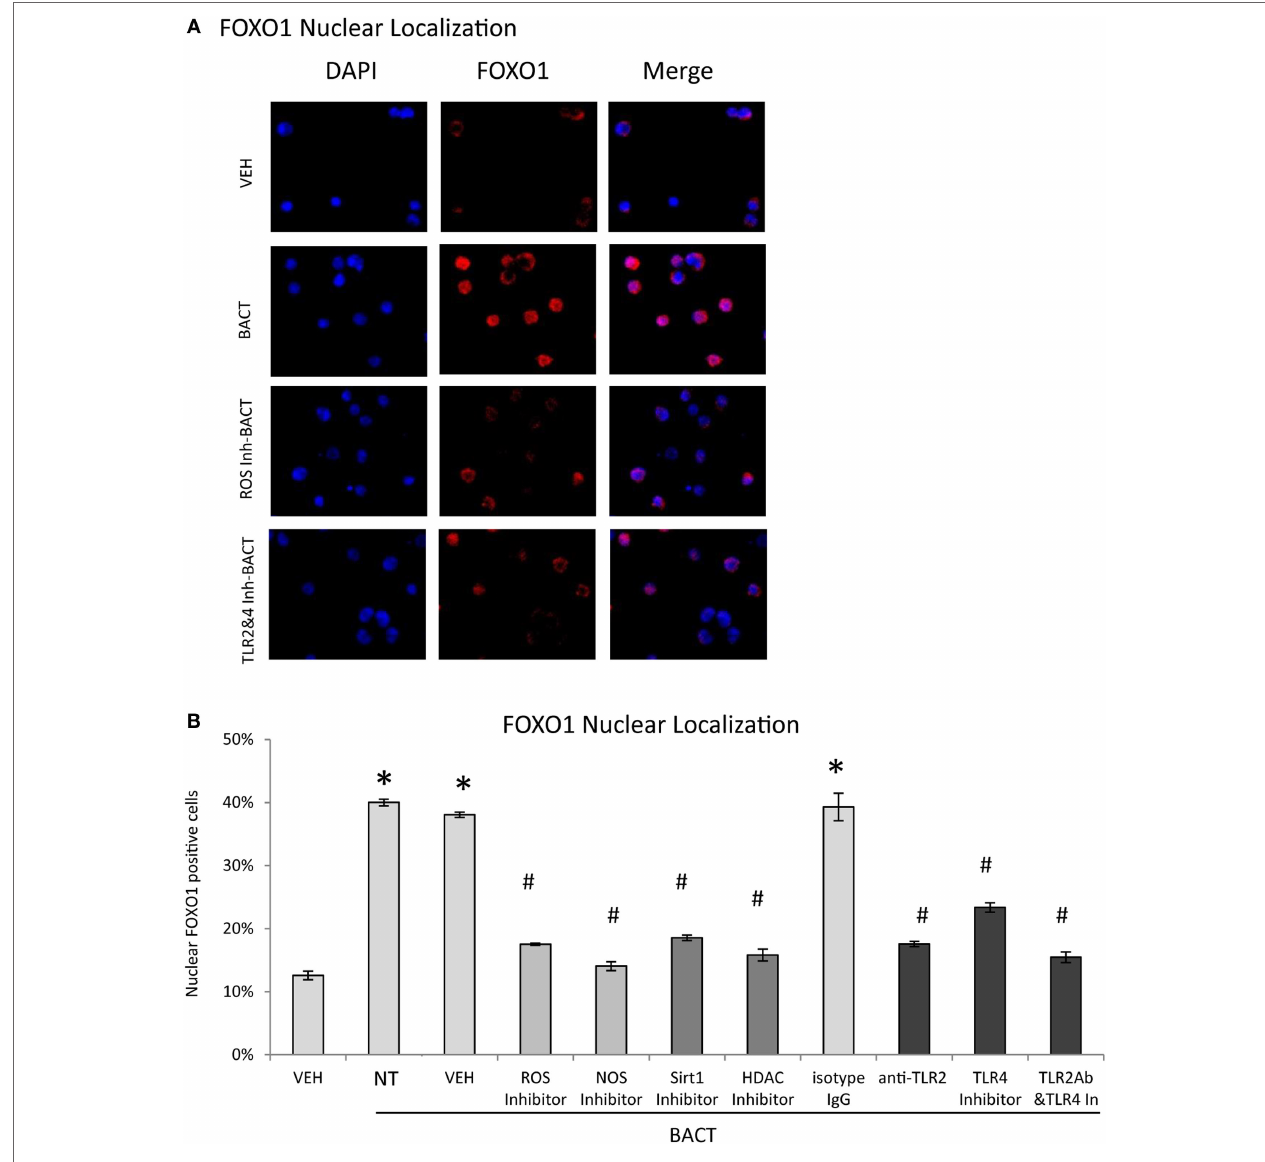
FigUre 4 | Bacteria stimulate FOXO1 nuclear localization through TLR signaling. (a) HL-60 neutrophils were incubated with TLR2 blocking antibody or matched control IgG or TLR4 inhibitor (TAK242) individually or combined. Cells were alternatively incubated with inhibitors to reactive oxygen species (ROS, NAC), NOS (L-NAME), Sirt1(Sirtinol), histone deacetylases (HDAC, Trichostatin A, TSA), or control vehicle alone, DMSO. (a) FOXO1 nuclear localization was determined by immunofluorescence using an antibody specific to FOXO1 and colocalization with DAPI nuclear stain. (B) Quantitation was determined by percent neutrophils with FOXO1 nuclear translocation. The data are representative of two or three independent experiments and expressed as the mean ± SEM from triplicate samples. *Significant difference between neutrophils incubated with bacteria or phosphate-buffered saline ( P < 0.05) or # treated with inhibitor and vehicle or isotype IgG control ( P <